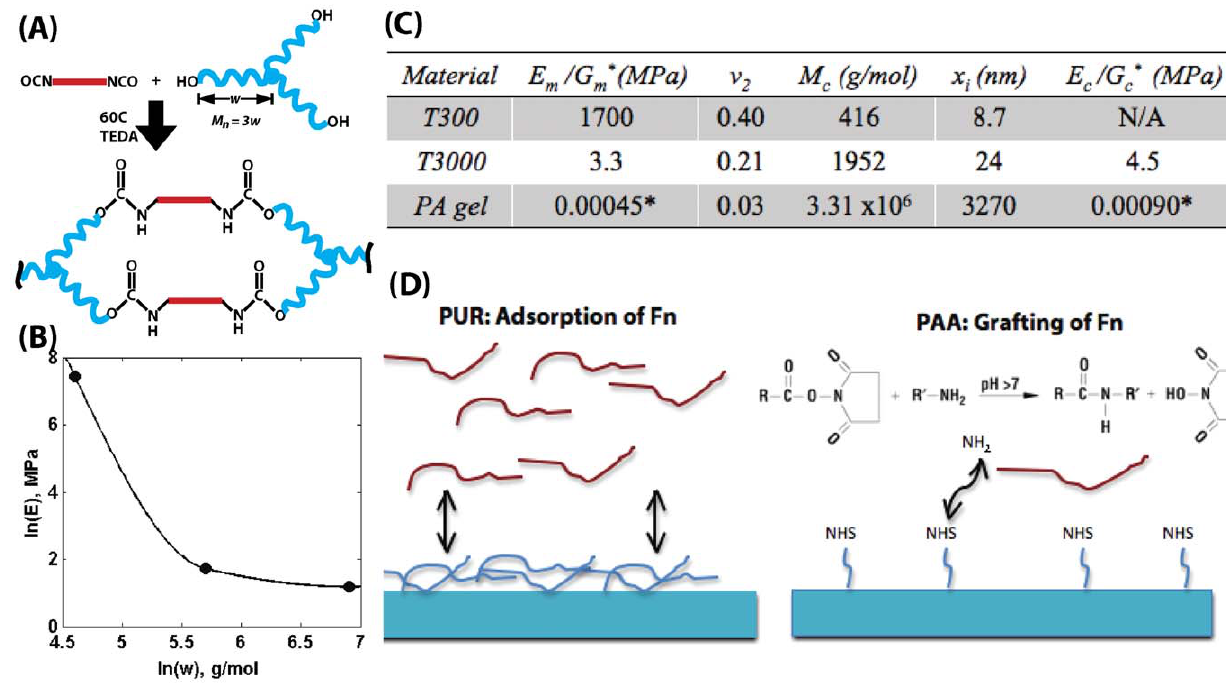
Figure 1. Schematic of materials synthesis and characterization. (A) Synthesis of PUR networks from an LDI quasi-prepolymer (red) and a poly( e -caprolactone-co-glycolide) triol with molecular weight M n =3 w , where w is the equivalent weight (g eq 2 1 ). (B) Experimental values of the elastic modulus E of PUR networks as a function of equivalent weight w . (C) Physical characteristics of polymer networks as calculated from rubber elasticity theory. E m and G m represents measured elastic and shear moduli, n 2 is the fraction of polymer in the swollen mass, M c is the calculated molecular weight between cross-links and E c and G c are the calculated elastic and shear moduli. (D) Schemes for providing a uniform surface concentration of fibronectin (Fn) for polyurethane networks and polyacrylamide gels.